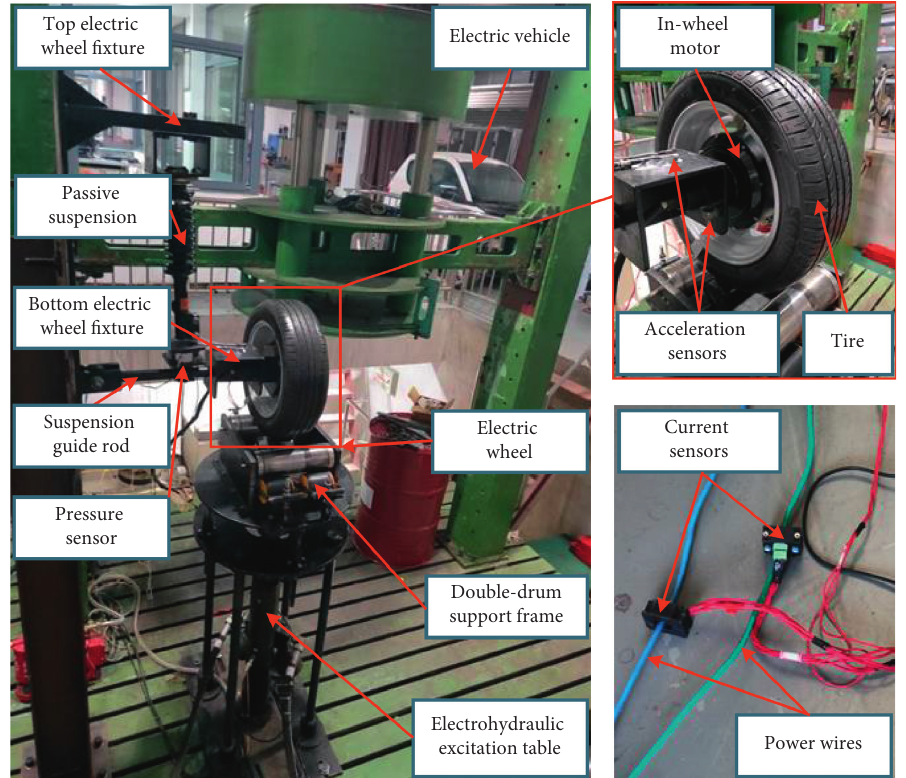
Figure 7: HDD-AS system-model validation test